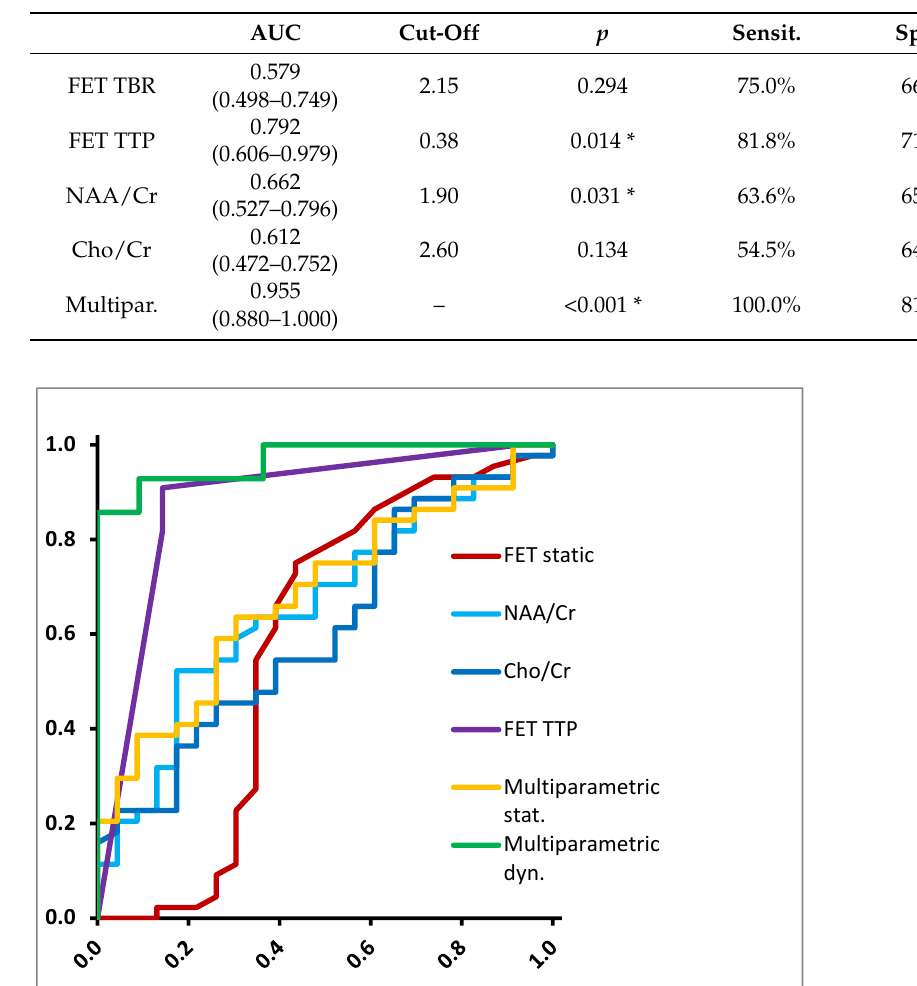
Figure 3. ROC curves for differentiation between glioblastoma and non-glioblastoma.